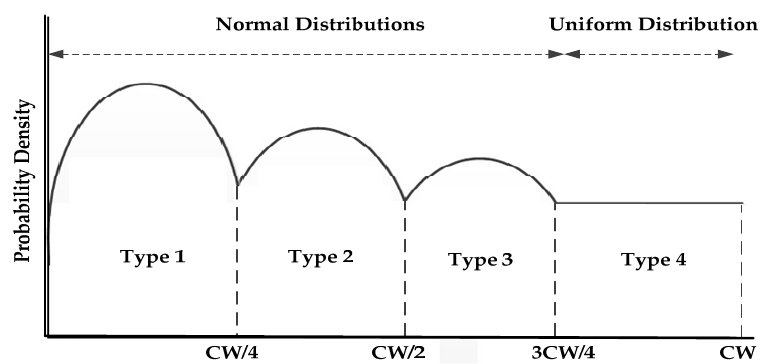
Figure 6. The back-off distribution used in PE-MAC.